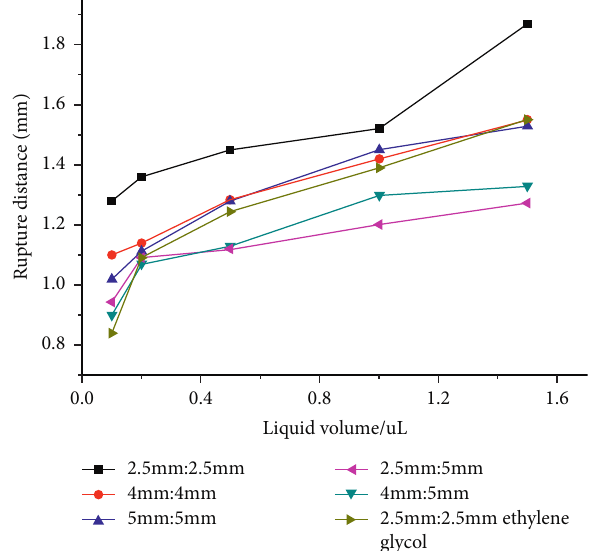
Figure 5: Curve of rupture distance-liquid volume. particles system when the diameter of upper particle equals 2.5 mm and Figure 6(b) shows the diameter of upper particle equals 5 mm. The red dots with the solid line represent the maximum force between two unequal particles, the blue triangles represent the maximum force between two equal particles whose size is equal to that of the upper particles in the unequal particle system, the black squares represent the maximum force between two equal particles whose size is shows the maximum liquid force of equal and unequal